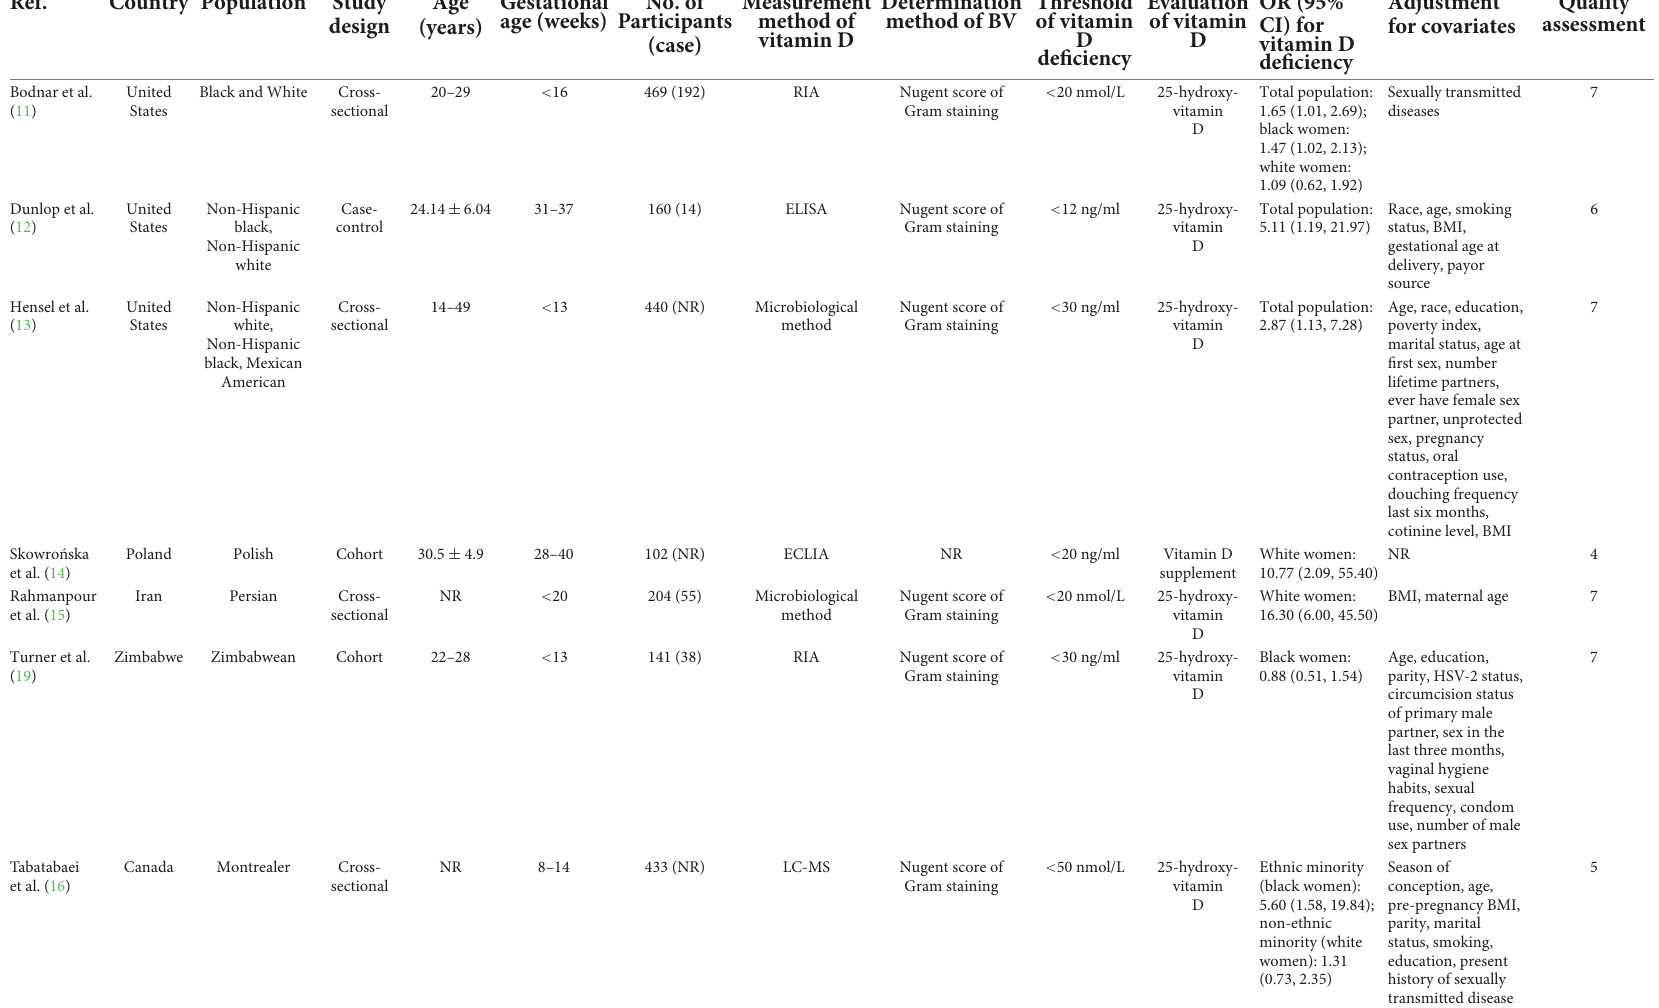
TABLE 1 Baseline characteristics of the included studies. Ref.